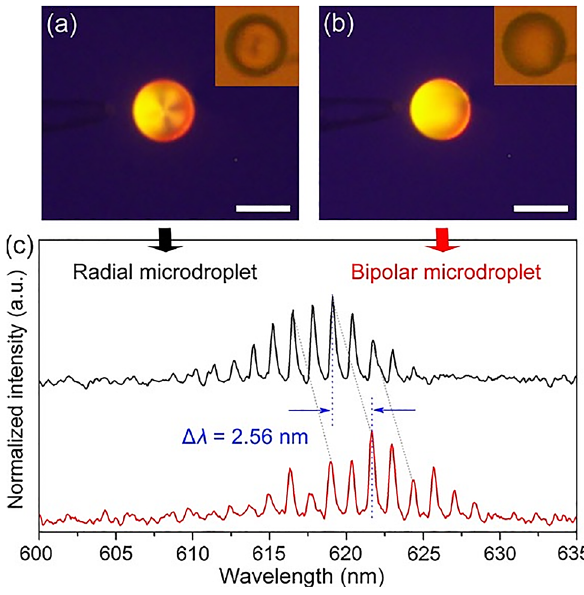
Figure 24: (a) POM image of lasing PBA-doped 5CB microdroplet in PBS with a pH of 6.0. The microdroplet exhibits a radial configura- tion. The corresponding micrograph of the radial microdroplet (top right inset). (b) POM image of the same microdroplet 3 min after adding10 μ Lhydrochloricacidsolution:themicrodropletundergoes orderingtransitionfromradial tothebipolarcon fi gurationas thepH decreases. Scale bars 50 μ m. (c) WGM lasing spectra of PBA-doped 5CB microdroplet with radial (black line) and bipolar (red line) con fi gurations